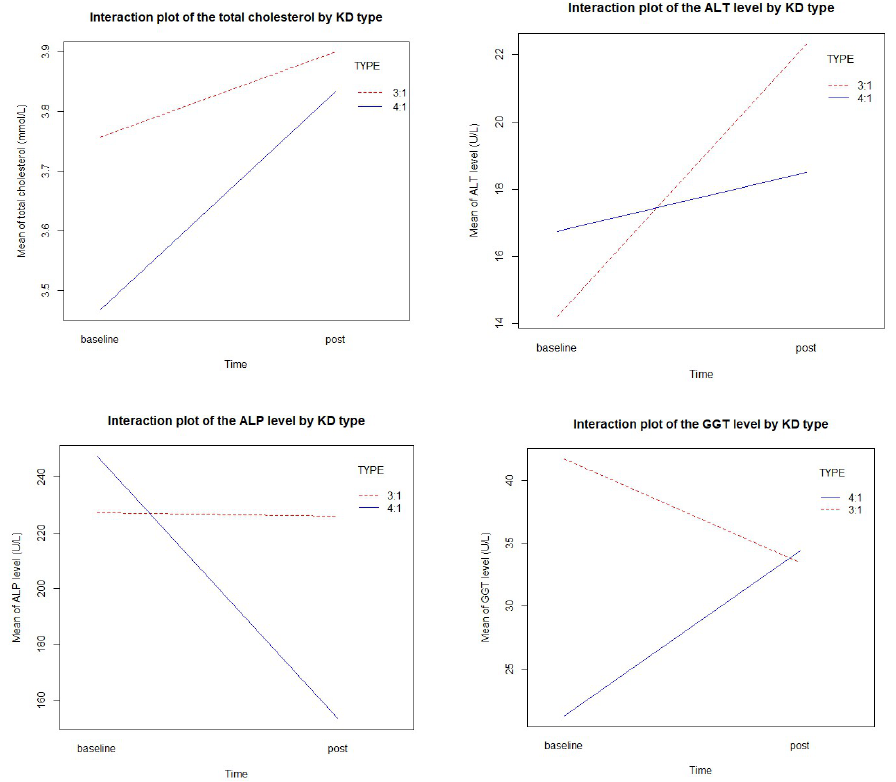
Figure 2. Interaction plots of the biochemical outcomes between time and cKD type. Table 3. Generalized estimating equation modeling.